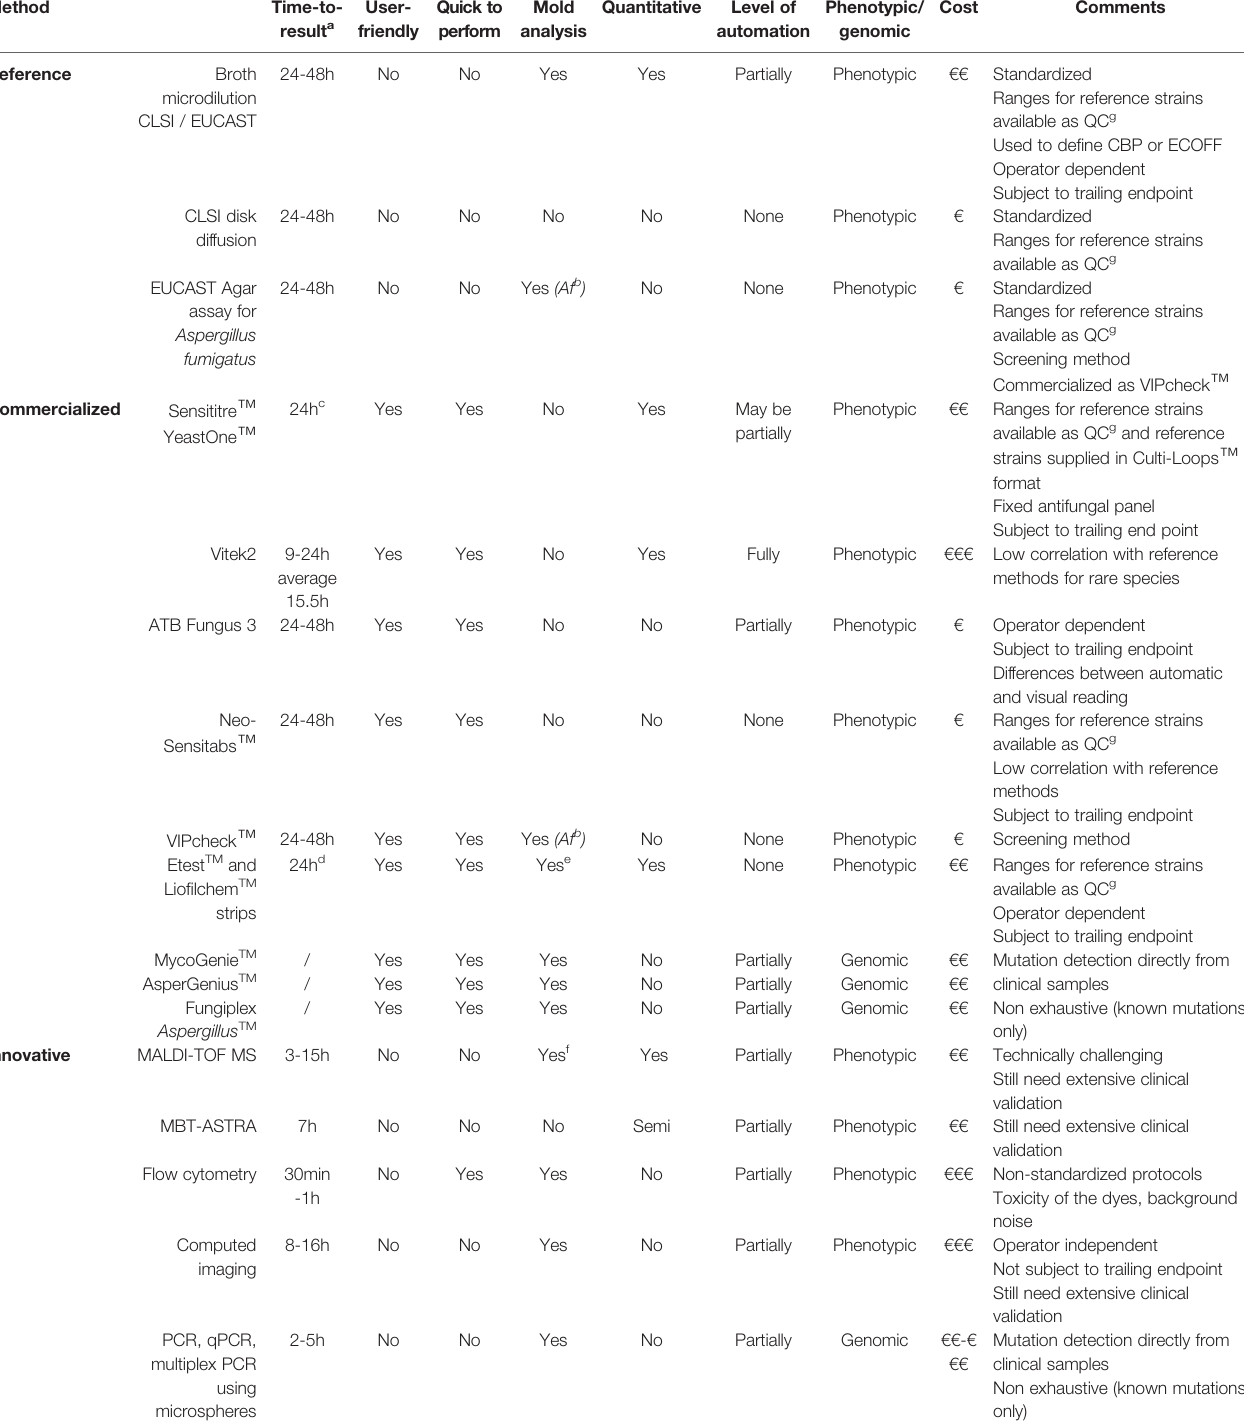
TABLE 1 | Current and innovative AFST